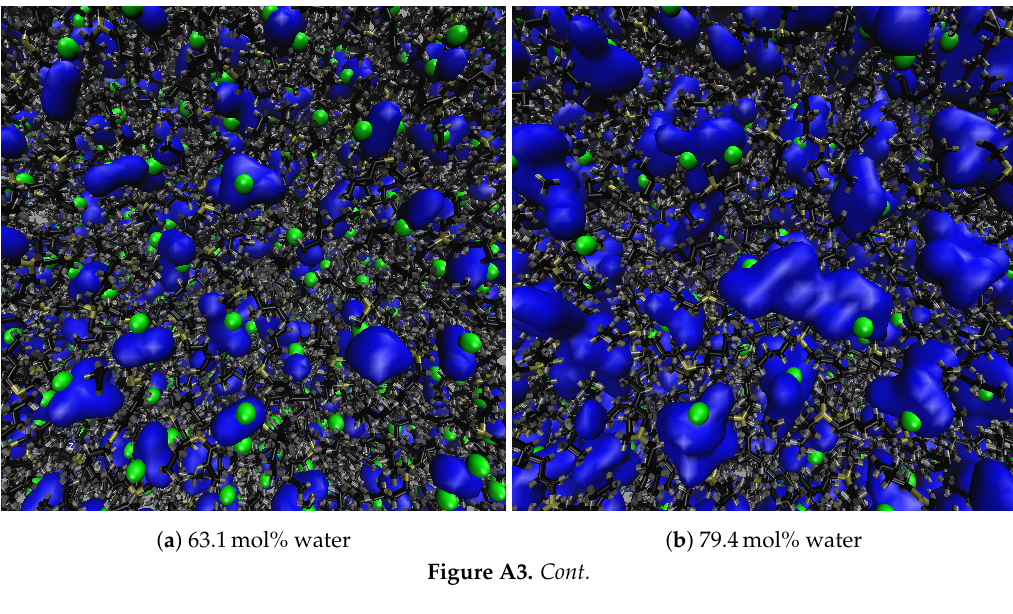
Figure A2. ( a ) Radial distribution functions of the end carbons on the TBP’s butyl chains (C TBPCl–water solution at 300K: Note that the 99.97mol% water data is an order of magnitude higher than the other data since it was scaled down by 1/10 to fit on the same plot; ( b ) Radial distances of the end carbons on the TBP’s butyl chains (C